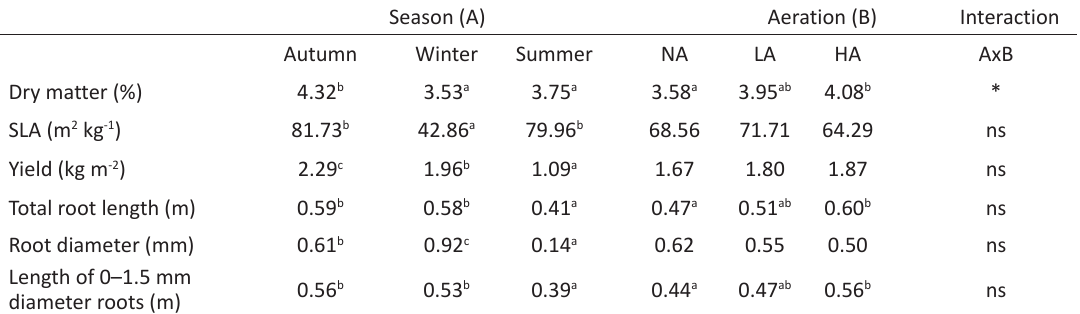
Table 1. Influence of aeration of the nutrient solution (no aeration -NA-, low aeration -LA-, high aeration -HA-) at harvest on the vegetative plant growth parameters (specific leaf area (SLA), % dry matter, yield, total root length, root diameter and length of 0 to 1.5 mm diameter roots) of baby leaf red lettuce cultivated in floating system in autumn, winter and summer cycles